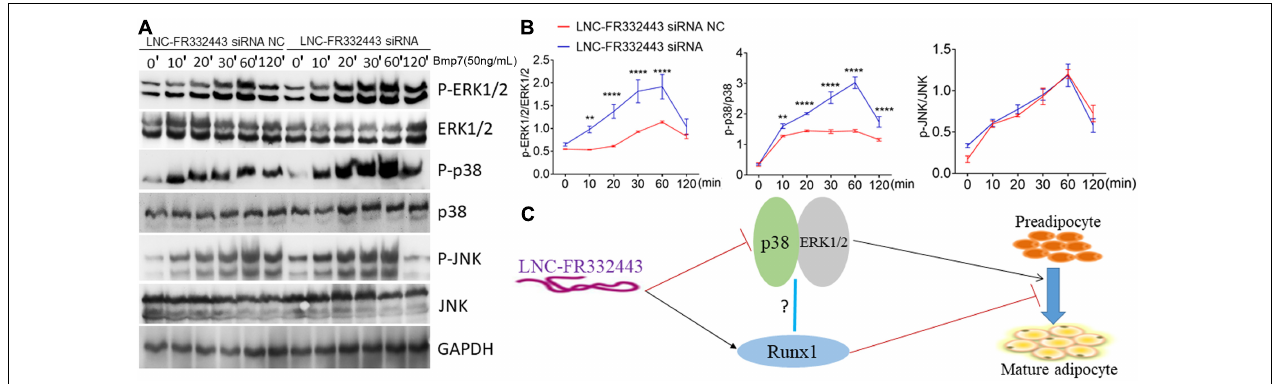
FIGURE 7 | Lnc-FR332443 inhibits 3T3-L1 cell differentiation by attenuating the phosphorylation of p38 and ERK1/2. (A) The phosphorylation levels of P-p38, P-ERK1/2 and P-JNK of the MAPK signaling pathway during 3T3-L1 preadipocyte differentiation with Lnc-FR332443 knockdown. (B) Quantification data of panel (A) . (C) A working model of the role of Lnc-FR332443 in the negative regulation of adipogenesis through Runx1 , MAPK-p38 and MAPK-ERK1/2. All the data are presented as mean ± SEM, N = 3, ** p < 0.01, **** p <